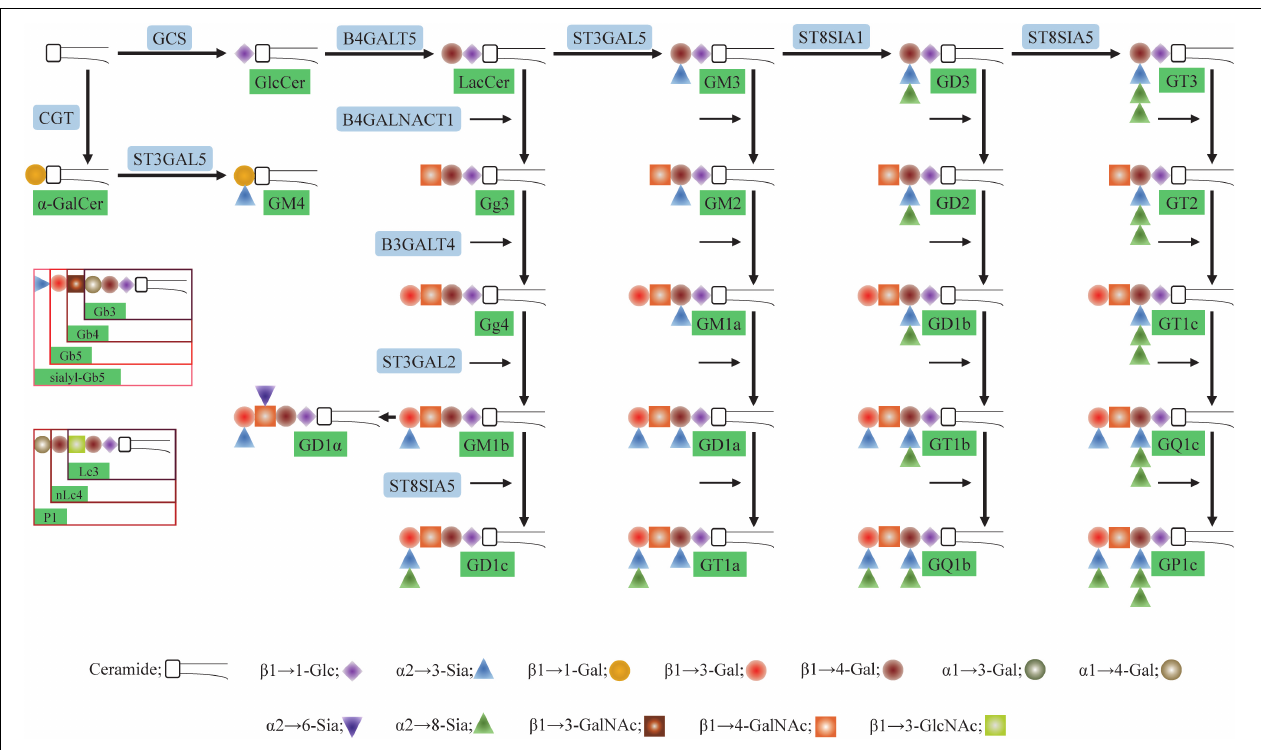
FIGURE 1 | Pathway for glycosphingolipids (GSLs) biosynthesis. Glc, glucose; Lac, lactosyl; Gal, galactose; GalNAc, N -acetylgalactosamine; GlcNAc, N -acetylglucosamine; Sia, sialic acid; b, globo-series; Lc3, lactotriaosylceramide; Lc4, neolactotetraosylceramide. The code names of gangliosides are according to Svennerholm (1980). G refers to ganglioside, the second letter refers to the number of sialic acids residues (M, mono-; D, di-; T, tri-; Q, quad-; P, pent-), and the number (1, 2, 3, 4) refers to the order of migration of the ganglioside on thin-layer chromatography (e.g., GM4 > GM3 > GM2 >